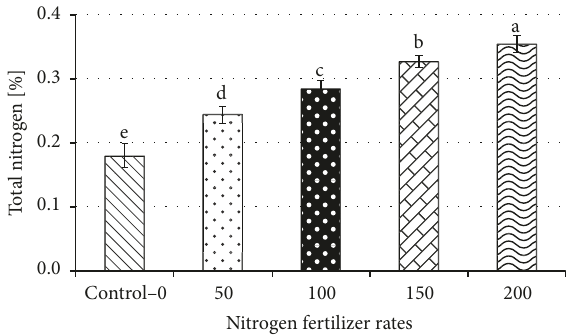
Figure 1: Effect of nitrogen fertilizer rates (control–0, 50, 100, 150, and 200 kg ha −1 ) on total soil nitrogen (Mean ± SD). Values across N fertilizer rates with different letters are significantly different ( P <